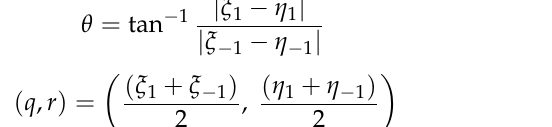
Figure 7. Two-point beam steering: ( a ) rotation, ( b ) linear x-shift, and ( c ) linear y-shift. The combination of separation ( p ), rotation ( 𝜃 ), and the shifting of two points ( q , r ) can steer the beam into two ROIs. Figure 8 shows a long-exposure image of beam steering into two ROIs. In each of the frames of the MEMS PLM, the beam is steered into a point